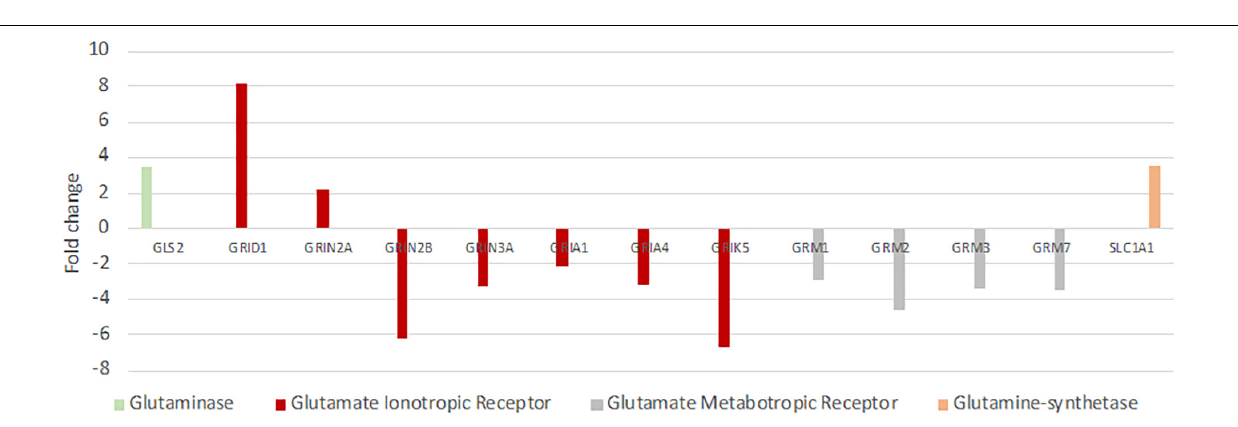
( Figure 2 ). To get a more detailed picture, we analyzed related GO terms and found that ∼ 70% of the genes related to “oxidative phosphorylation,” “respiratory electron transport chain”